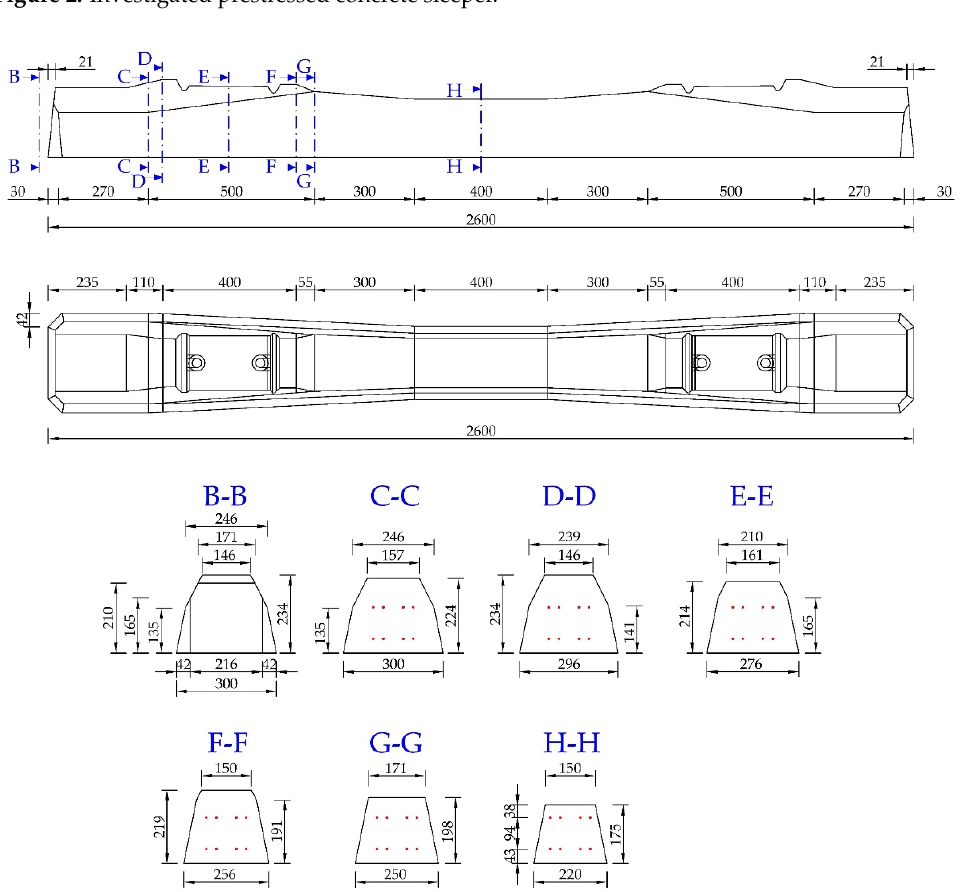
Figure 3. Dimensions of specimens (prestressed sleeper B70 W-49 G).